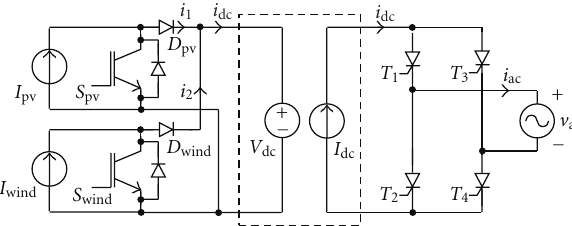
Figure 5: Simplified equivalent circuit of the proposed system.